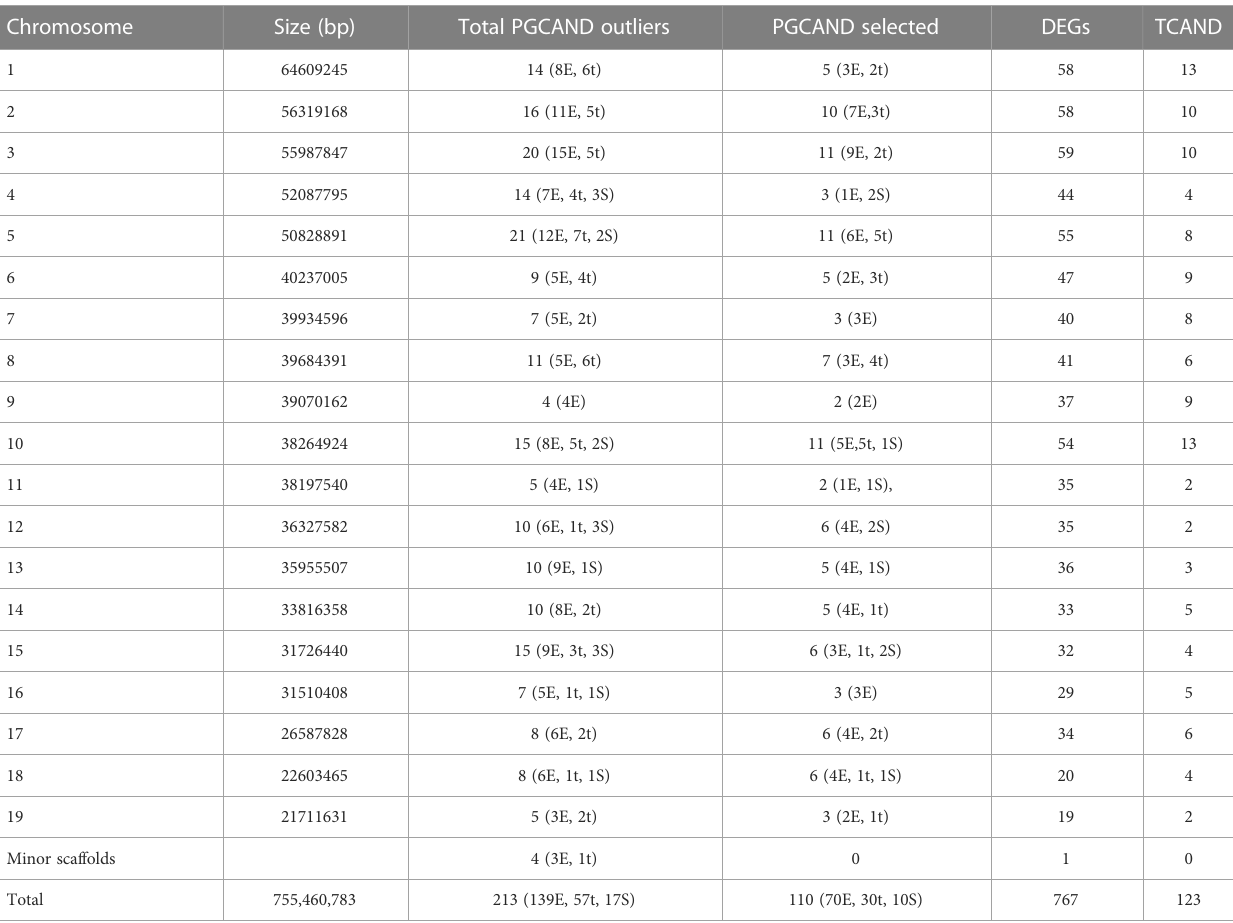
TABLE 3 Genomic location of consistent SNPs detected in Cerastoderma edule following population genomics and transcriptomics approaches along with the differentially expressed genes reported by Pardo et al. (2022).